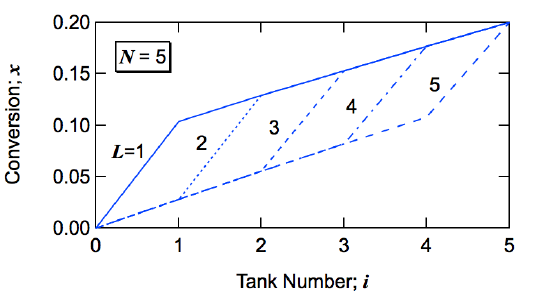
Figure 9. Development of monomer conversion to polymer x with the progress of tank number i for N = 5.